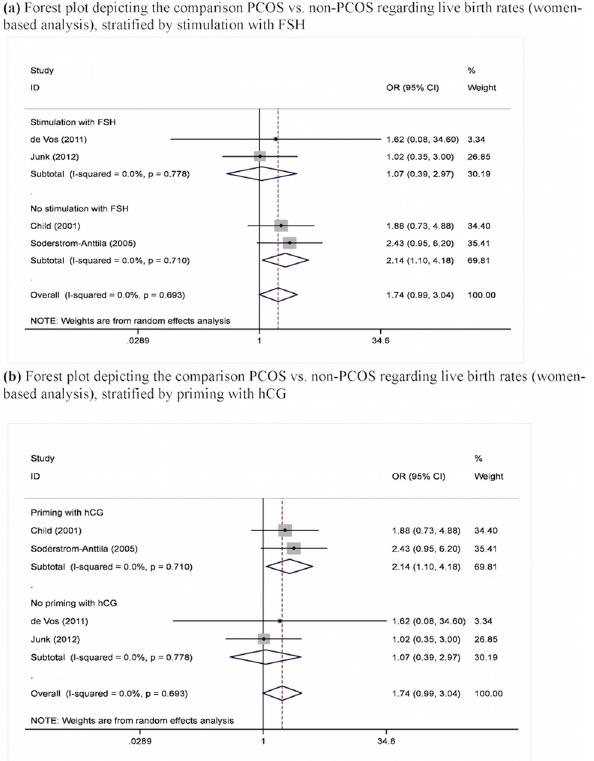
Fig 2. (a). Comparison PCOS vs. non-PCOS regarding live birth rates (women-based analysis), stratified by stimulation with FSH. (b) Comparison PCOS vs. non-PCOS regarding live birth rates (women-based analysis), stratified by priming with